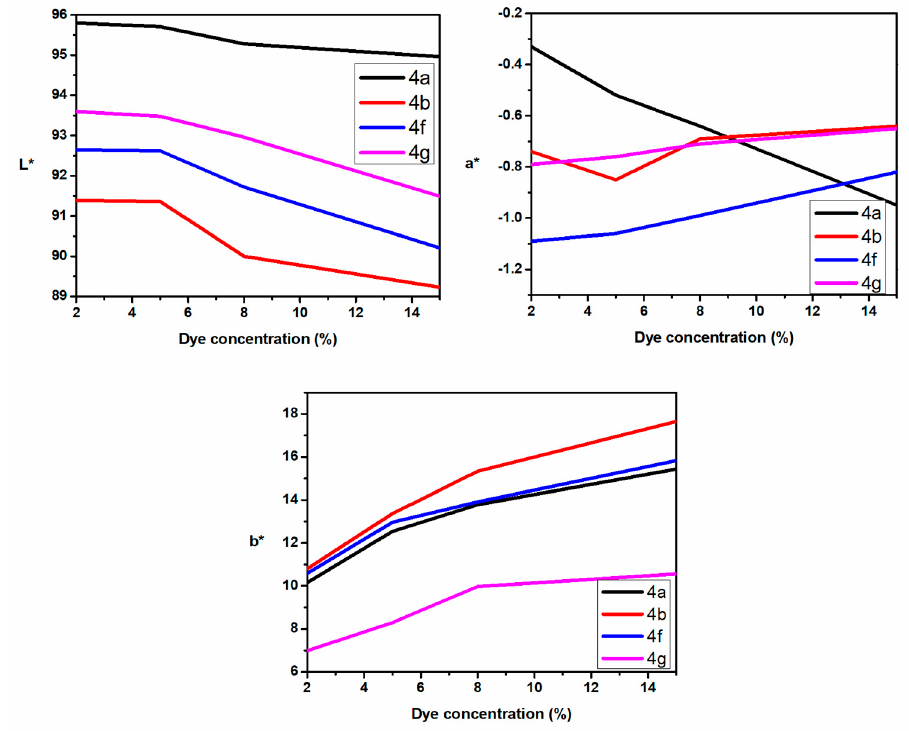
Figure 6. The dependence of CIEL*a*b* parameters on the dye concentration for dyes 4a , 4b , 4f , and 4g . The azo dye behavior in the color space indicates the prevalent hydrazo tautomer presence in the azo-hydrazo tautomerism, this fact being in accordance with the dye structural information obtained by the physico-chemical analyses presented above, and UV-VIS, 1 H NMR, and 13 C NMR spectra simulations using the DFT